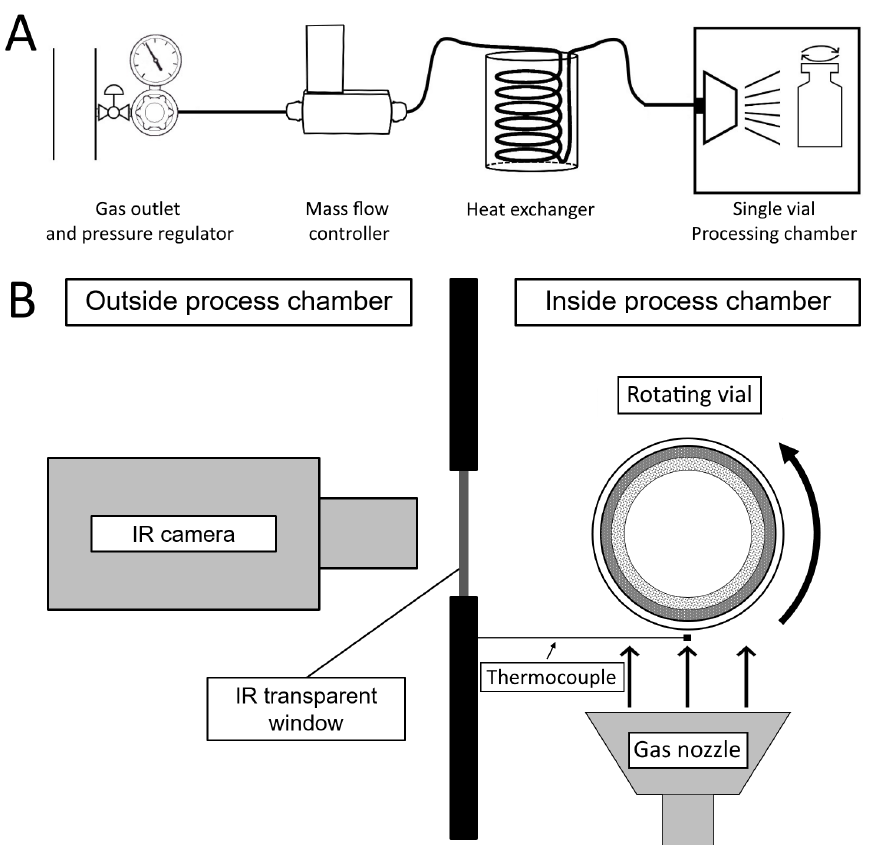
Figure 3. Schematic representation of the cooling system during spin freezing. ( A ): Scheme showing how pressurized air travels from the gas outlet through a pressure regulator, after which the gas flow rate is subsequently determined by a mass flow controller. The pressurized air then passes through the liquid nitrogen heat exchanger before flowing through the gas diffuser and cooling the rotating vial within the single-vial processing chamber. ( B ): Top view of the experimental setup, showing the rotating vial, the outlet of cold gas from the gas nozzle, the gas temperature measurement thermocouple, and the IR camera located outside the chamber measuring through a germanium